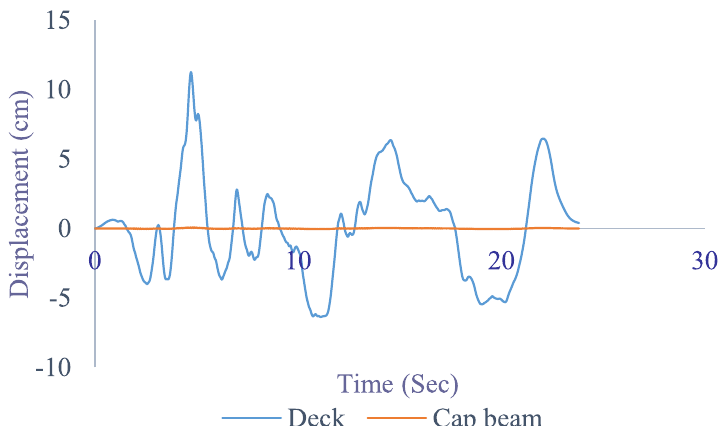
Fig. 20 The lateral displacement of points Deck and Cap beam in the transverse direction (Y) in model 4 under the Tabas earthquake